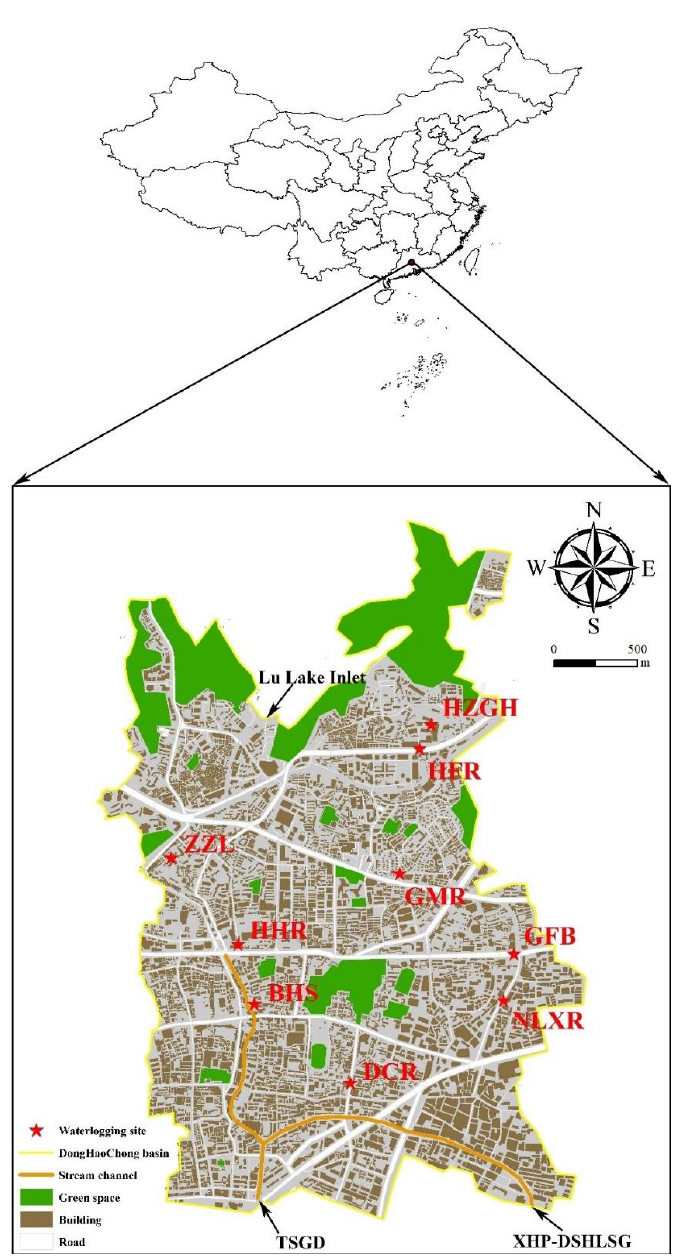
Figure 1. Location of the DongHaoChong basin and the spatial distribution of main waterlogging sites. ZZL, Zhuziliao; HHR, Huanghua Road; BHS, Beiheng Street; DCR, Dongchuan Road; NLXR, Nonglinxia Road; GFB, Guangfa Bank; GMR, Guangming Road; HFR, Hengfu Road; HZGH, Hengzhigang Hospital.